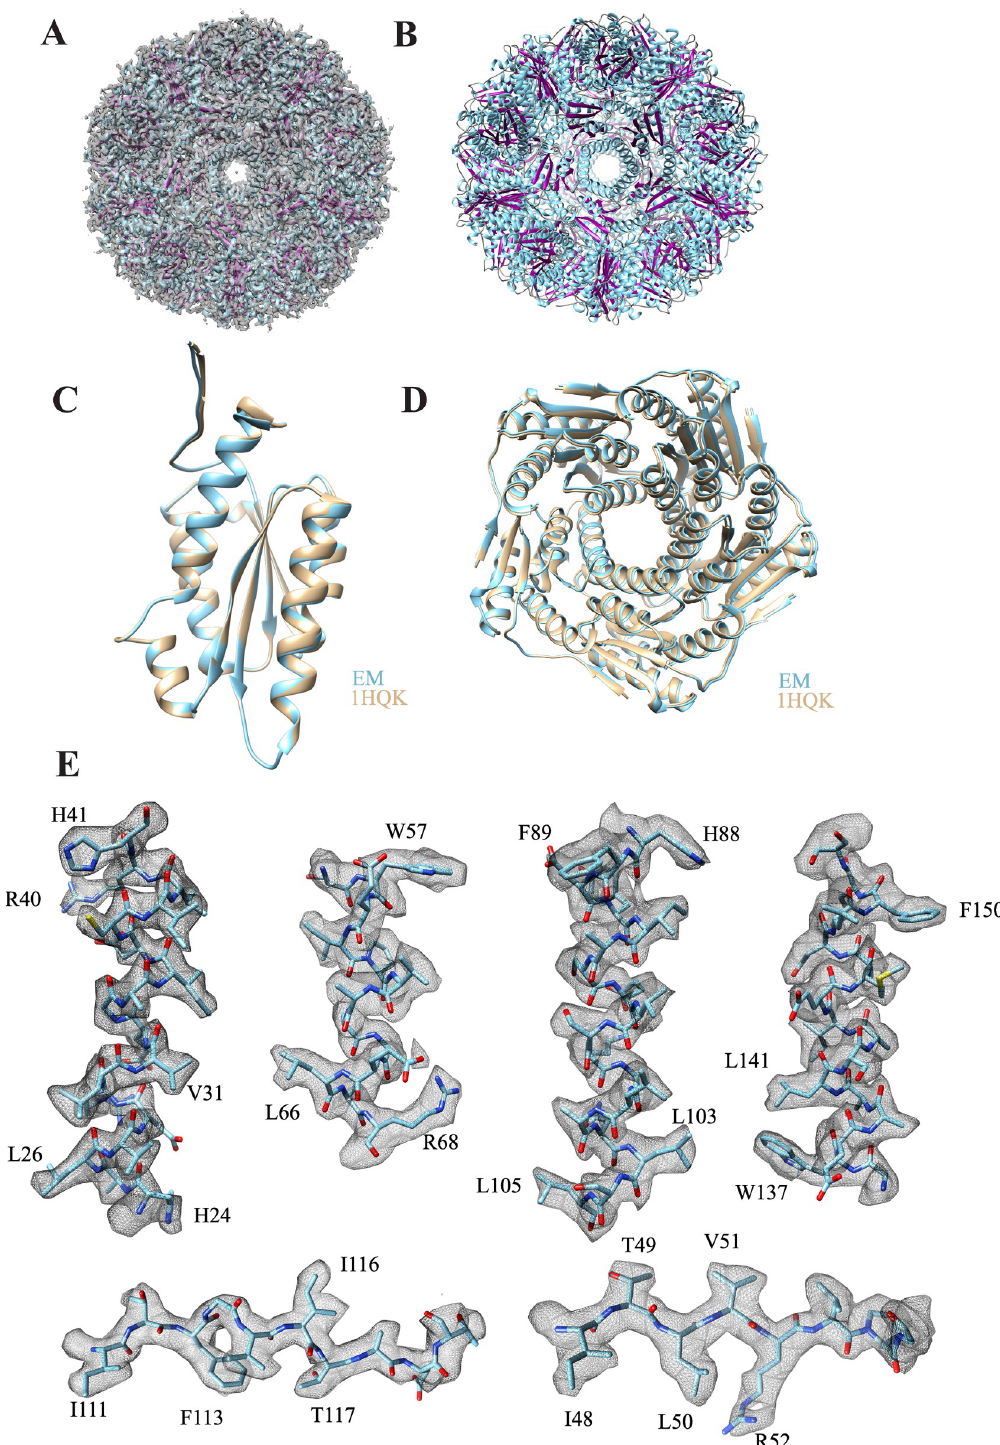
Fig 5. Structural details of LS. ( A ) The atomic model (7X7M) composed of 60 monomers arranged in icosahedral symmetry is superimposed into the cryo-EM map. ( B ) The ribbon diagram of LS is viewed from the 5-fold axis. ( C ) The atomic model of the monomer based on the cryo-EM map (cyan) is superimposed on the x-ray crystal structure (tan, 1HQK). The RMSD of both structures is 0.174 Å for the 154 C α atoms. ( D ) The pentamer of LS based on the cryo-EM map (cyan) coincides with that of the x-ray crystal structure of Aquifex aeolicus LS (tan, 1HQK). (E) Representative secondary structural elements of the LS complex are shown within the cryo-EM map. https://doi.org/10.1371/journal.pone.0275487.g005 PLOS ONE | https://doi.org/10.1371/journal.pone.0275487 October 3,